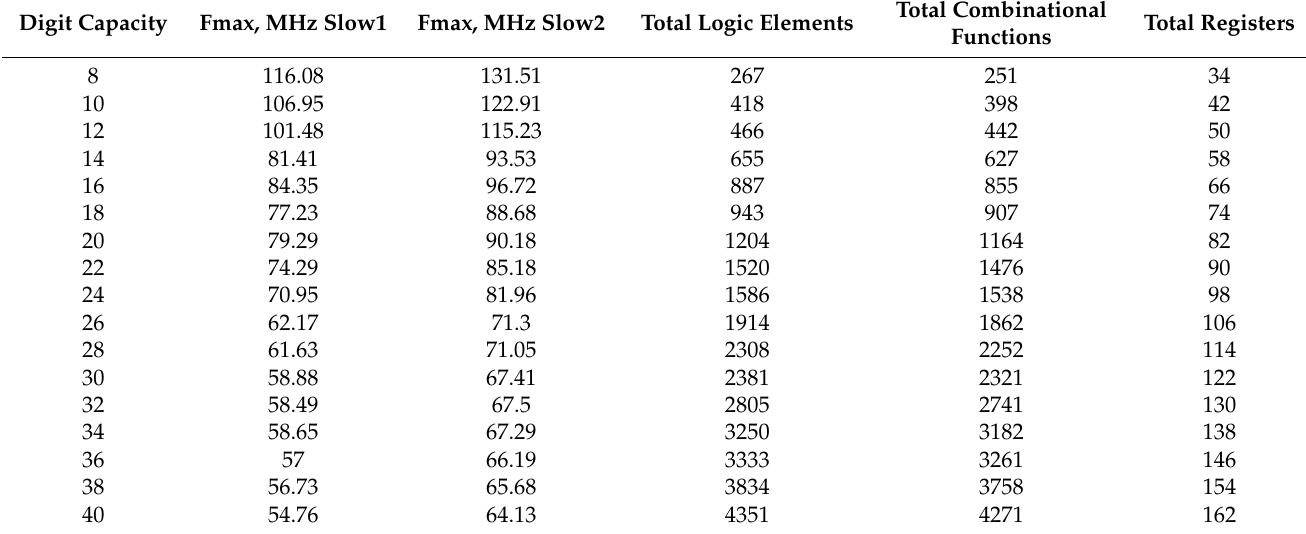
Table 7. Characteristics of the TBTM of two codes.